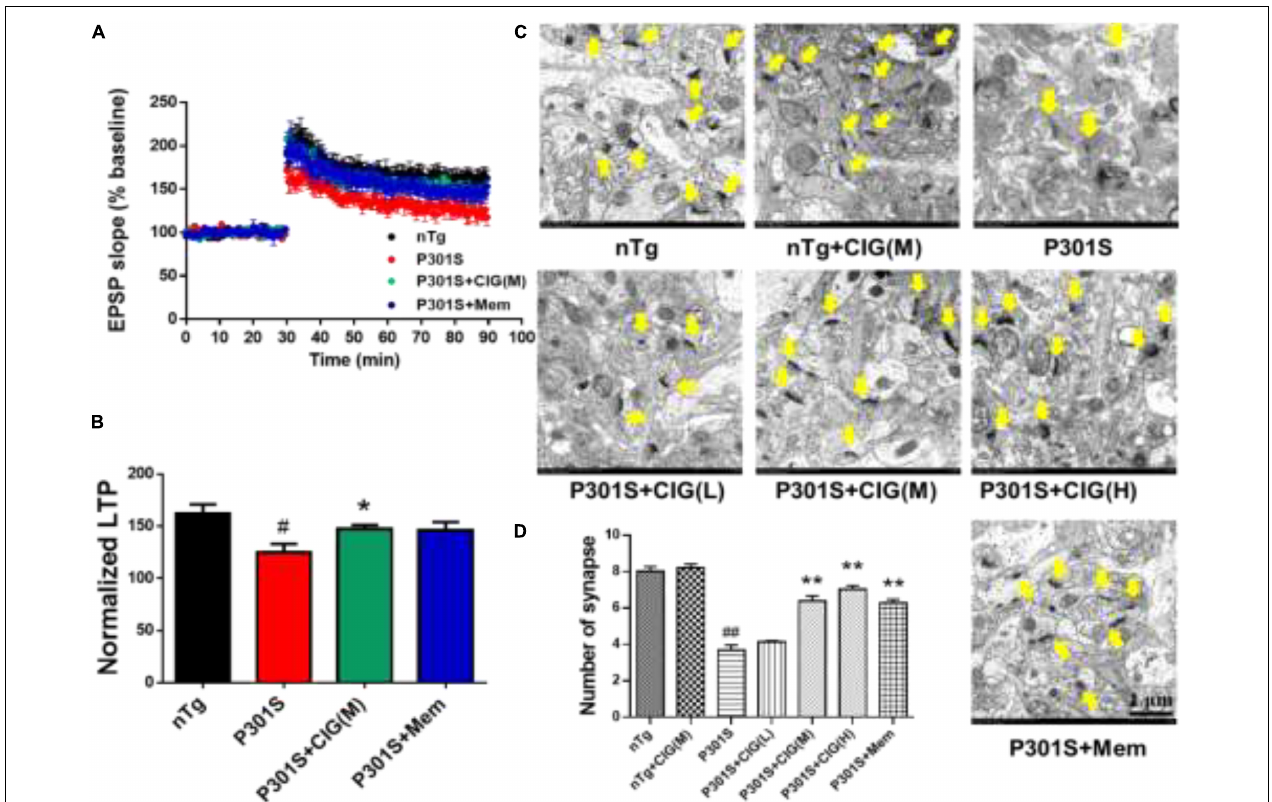
FIGURE 2 | Cornel iridoid glycoside (CIG) protects synaptic plasticity and synapse ultrastructure in the hippocampus of P301S mice. (A) Long-term potentiation (LTP) was induced by high-frequency stimulus trains after 30-min baseline stimulation. The field excitatory postsynaptic potentials (fEPSPs) were recorded for 60 min. (B) Statistical analysis of average LTP responses between 0 and 60 min after high-frequency stimulus trains. (C) Representative images of the ultrastructure of synapses in the hippocampus of mice detected by transmission electron microscopy (yellow arrow). Magnification: 4,000 × ; scale bar = 1 µ m. (D) Quantitative analysis of the number of synapses in the hippocampus of mice. Data are expressed as mean ± SEM; n = 6 each group. # P < 0.05, ## P < 0.01, P301S transgenic mice vs nTg control mice; * P < 0.05, ** P < 0.01, drug-treated P301S mice vs saline-treated P301S mice. nTg, non-transgenic control mice; P301S, P301S transgenic mice; CIG(L), CIG 50 mg/kg, low dose; CIG(M), CIG 100 mg/kg, medium dose; CIG(H), CIG 200 mg/kg, high dose; Mem, memantine 5 mg/kg.